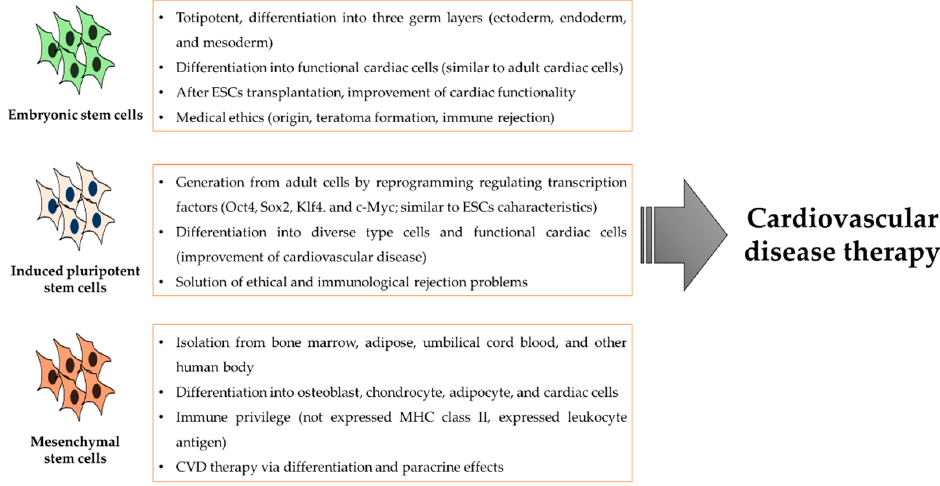
Figure 2. A diagram of diverse stem cells for the treatment of CVD.